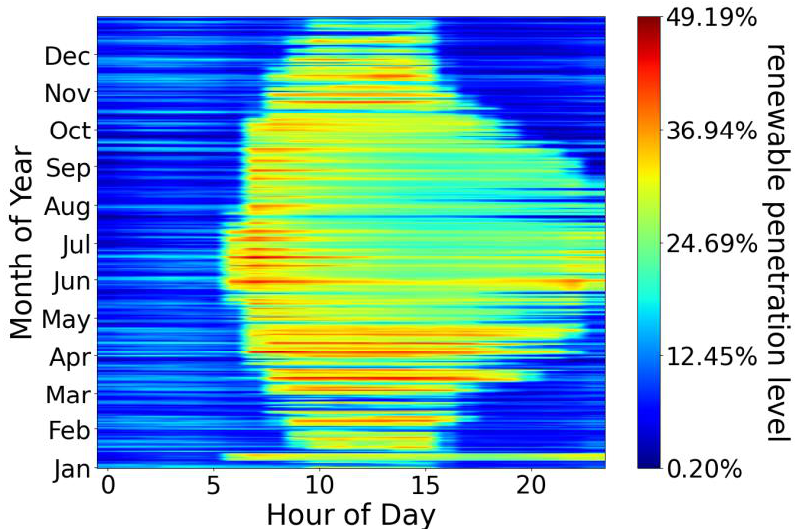
Figure 2. Renewable penetration across one year.